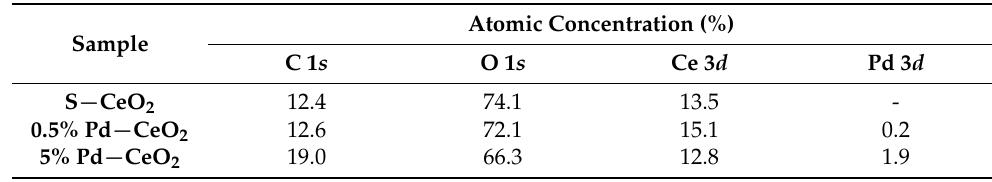
Figure 2. XPS spectra of S − CeO 2 , 0.5% Pd − CeO 2 , and 5% Pd − CeO 2 : ( a ) Survey scan, ( b ) Ce 3d, ( c ) Pd 3d, ( d ) O 1s, and ( e ) C 1s. Table 2. Atomic concentration of C 1s, O 1s, Ce 3d, and Pd 3d of S − CeO 2 , 0.5% Pd − CeO 2 , and 5% Pd − CeO 2 .